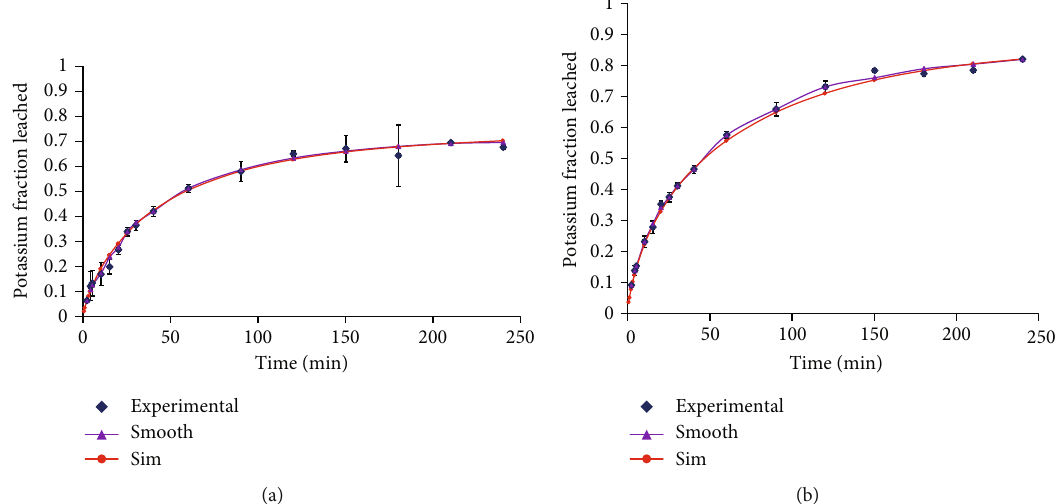
Figure 4: Sample model simulation for the di ff usion of potassium in potato (a) spheres preheated and leached at 70 ° C and (b) cubes preheated at 80 ° C and leached at 70 ° C (error bars: standard